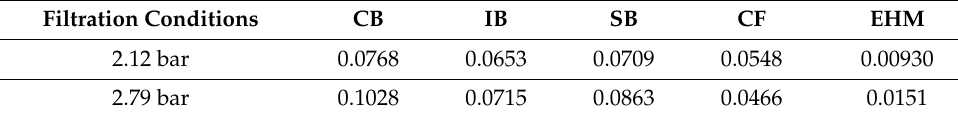
Table 11. RMSE results obtained in Example 4 at 2.5 m/s and different